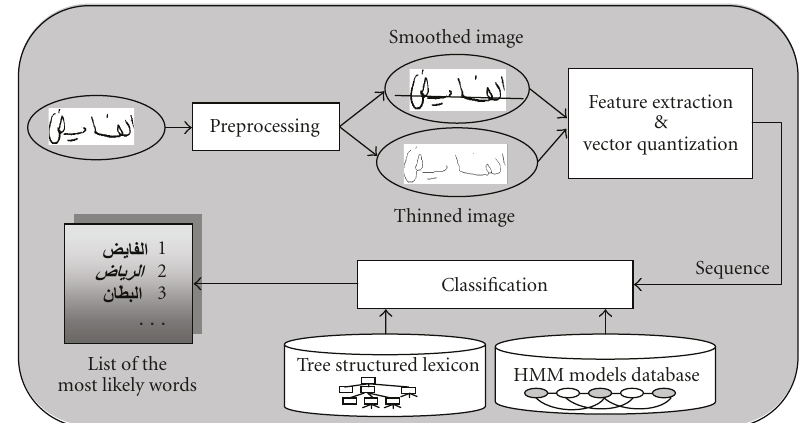
Figure 2: Recognition system architecture showing the main stages which must be carried out to identify the word image.